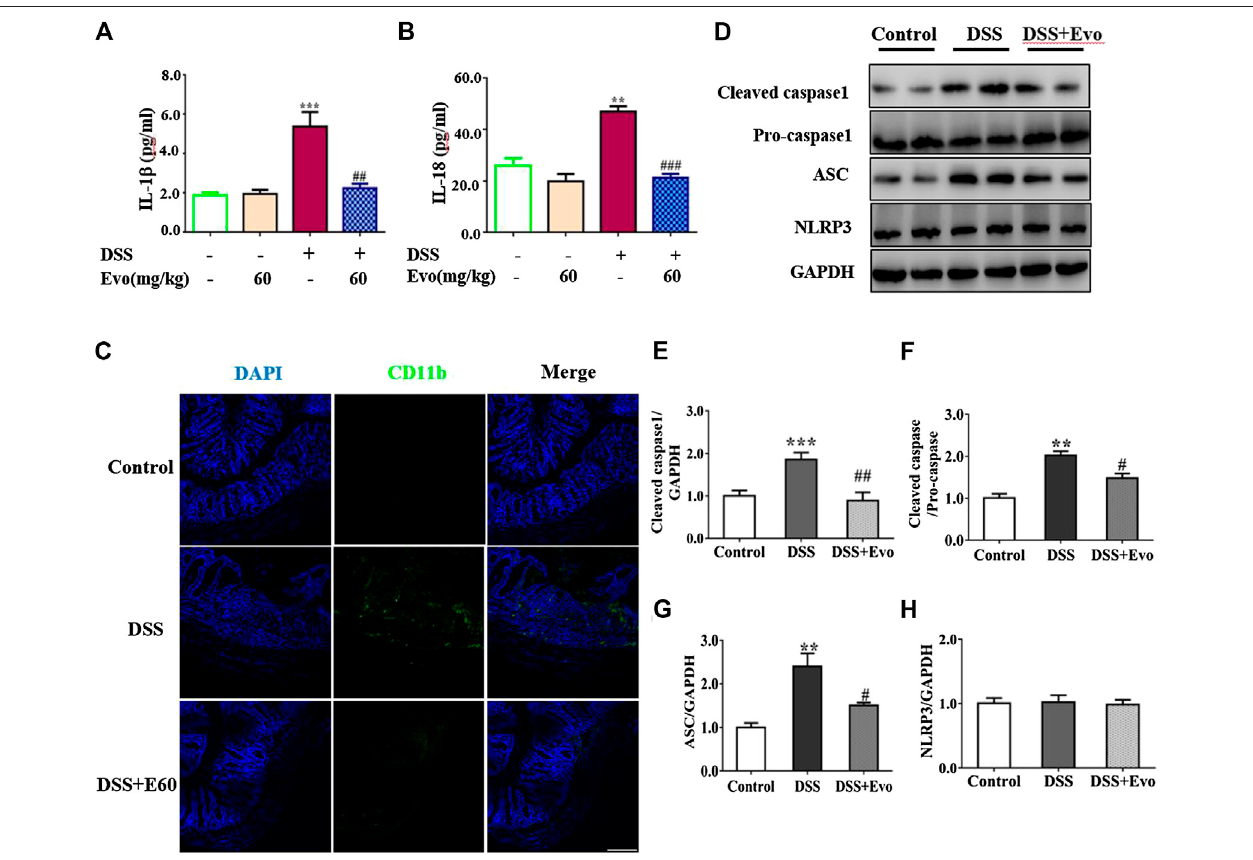
FIGURE 3 | Evodiamine suppressed in fl ammation and decreased activity of NLRP3 in fl ammasome in DSS-induced mice. (A,B) IL-1 β and IL-18 in colonic tissues weredetermined byELISA,respectively. (C) Sections ofcolonwereimmunostainedwithDAPI(blue)and antiCD11b-FITC (green). Scalebars,100 μ m. (D) Expressions ofcleavedcaspase1,pro-caspase1,ASCandNLRP3incolonweredeterminedbyimmunoblot. (E – H) Quanti fi cationof (D) datawereshownasmean ± SEM.** p < 0.01 and *** p < 0.001 compared with control, # p < 0.05, ## p < 0.05, and ### p < 0.001 compared with DSS-induced group.